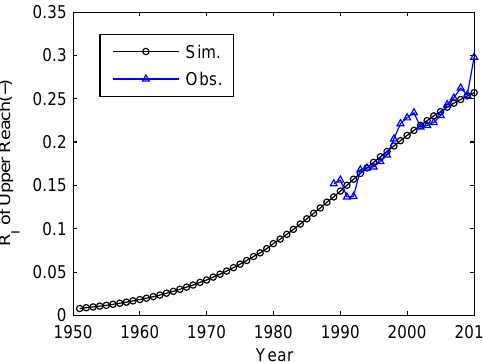
Figure 8. Ratio of irrigated area ( R I ) of the upper reach of the Tarim